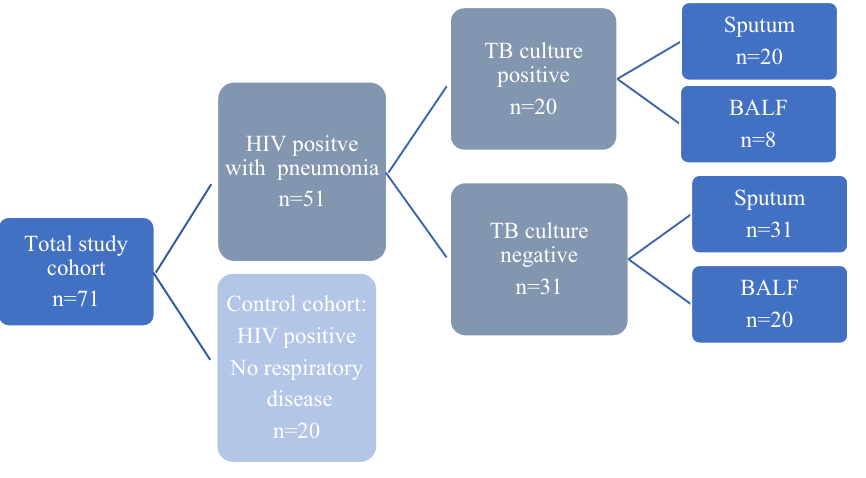
Figure 1. Participant cohorts included in the